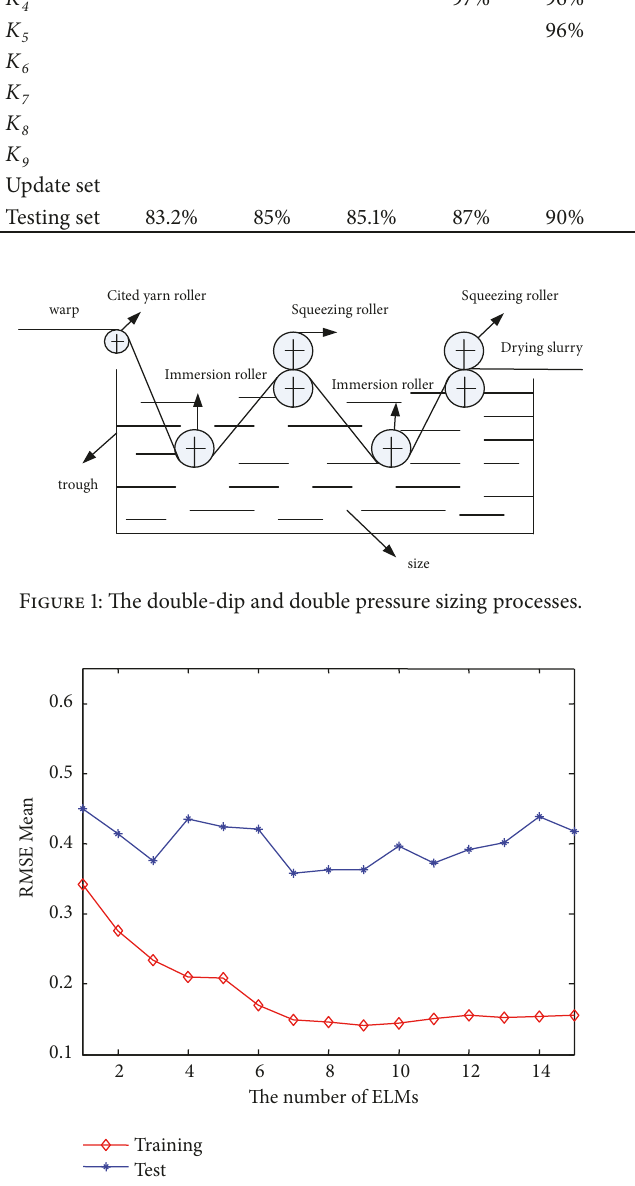
Figure 2: The training and testing errors of the ILES with different parameters 𝑇 푘 .